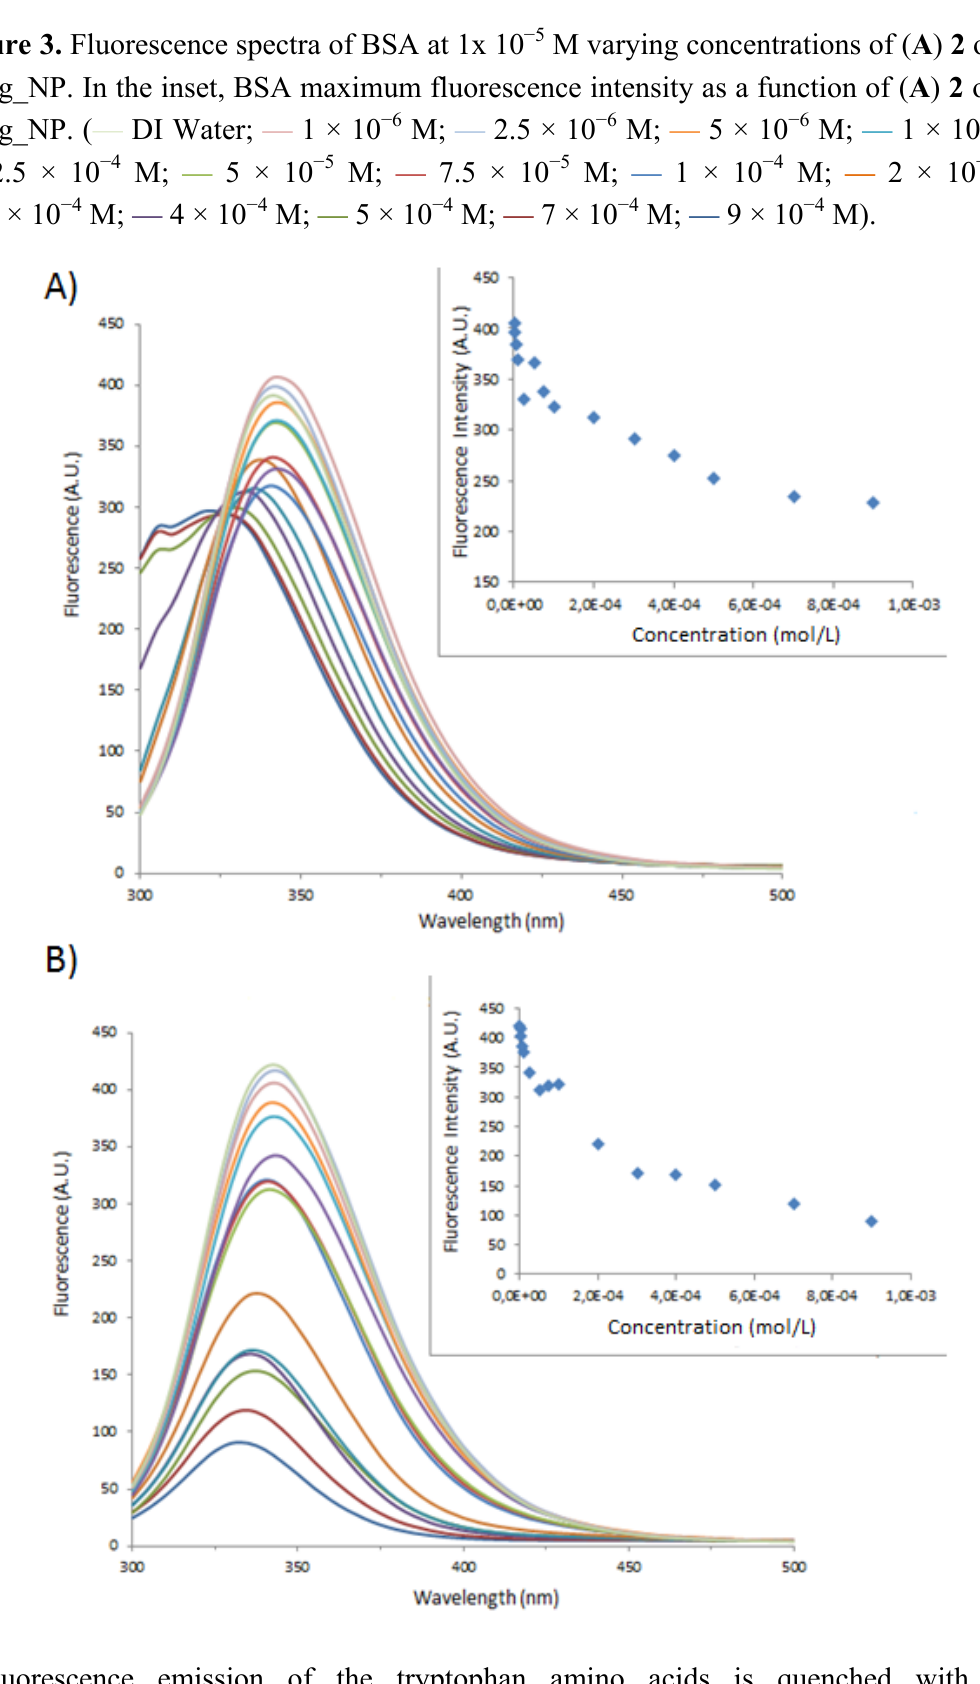
Figure 3. Fluorescence spectra of BSA at 1x 10 − 5 M varying concentrations of ( A ) 2 or ( B ) 2 _Ag_NP. In the inset, BSA maximum fluorescence intensity as a function of ( A ) 2 or ( B ) 2 _Ag_NP. (— DI Water; — 1 × 10 − 6 M; — 2.5 × 10 − 6 M; — 5 × 10 − 6 M; — 1 × 10 − 5 M; — 2.5 × 10 − 4 M; — 5 × 10 − 5 M; — 7.5 × 10 − 5 M; — 1 × 10 − 4 M; — 2 × 10 − 4